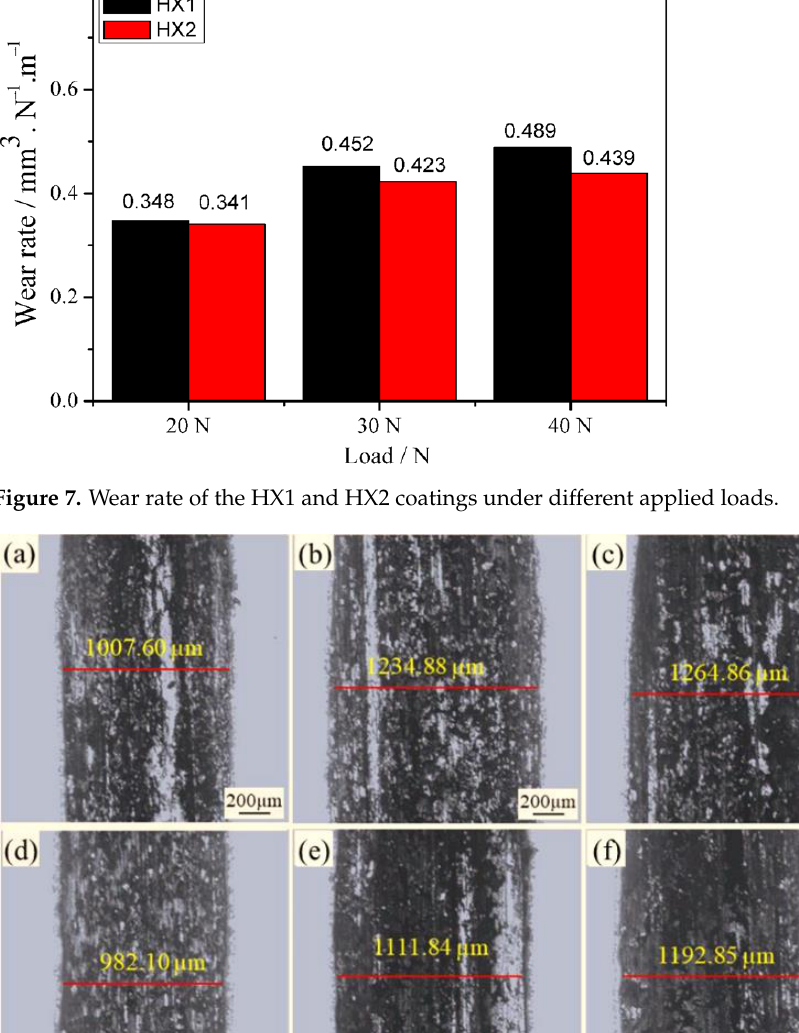
Figure 9. Two-dimensional (2D) profiles of the cross-section of the wear scars under different loads. Figure 10a–f shows the worn surface morphology of the HX1 and HX2 coatings ex- amined in detail using SEM after being subjected to sliding wear under different loads. From Figure 10a, it can be seen there were flake debris, spalling from the surface of the HX1 coating, and broken debris under a load of 20 N. When the load increased to 30 N, flake debris, spalling, and broken debris were aggravated, and cracks appeared, as shown